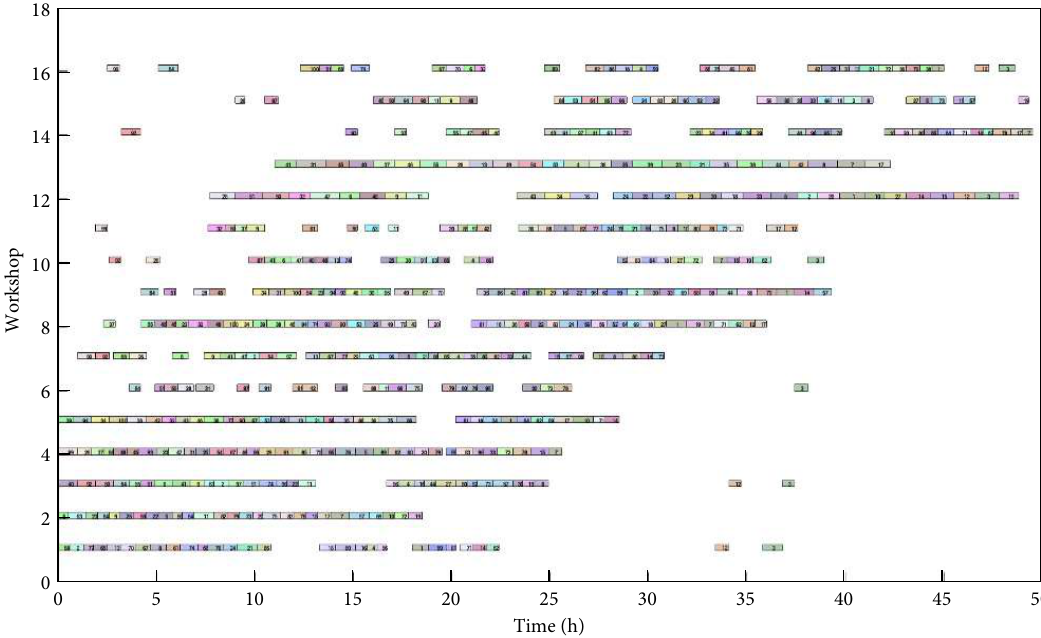
Fig. 7 Optimal scheduling plan of Simulation